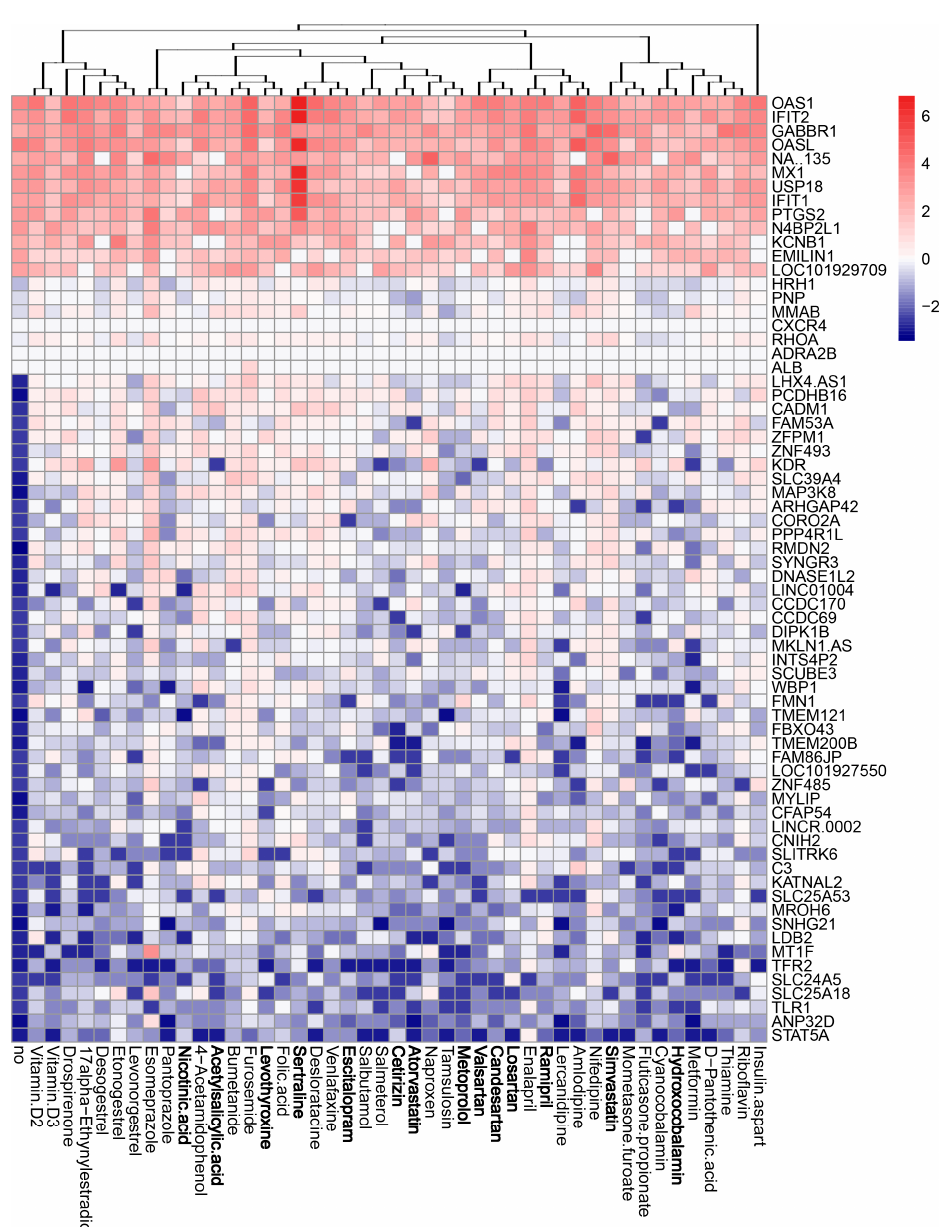
Figure 5. Effect of 45 compounds on polyadenylated host RNAs in FLUAV-infected RPE cells. RPE cells were treated with 10 μ M compounds and infected with FLUAV at moi 1. After 8 h, total RNA was isolated, and a fraction of polyadenylated RNA was sequenced. A heatmap of the most variable genes affected by FLUAV infection is shown (2.5 < log2FC < − 2.5). Rows represent gene symbols, columns represent treatments with drugs, clustered based on structural similarity. Drugs marked in bold are compounds which were predicted to affect FLUAV–host cell interactions. Each cell is colored according to the log2-transformed expression values of the samples, expressed as fold change relative to the non-treated mock-infected control.